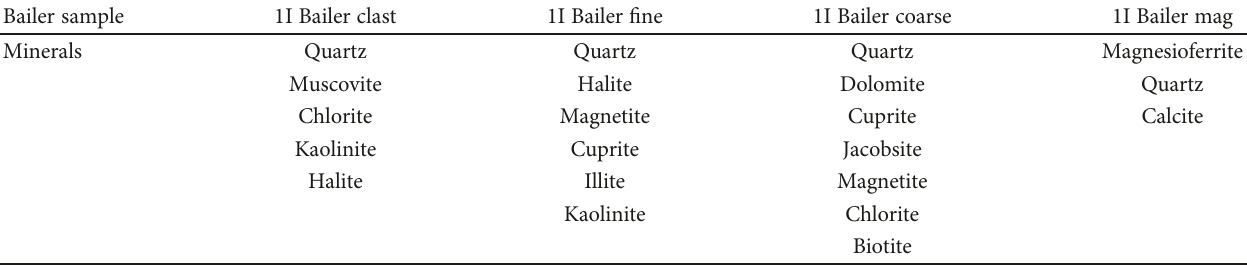
Table 10: Minerals identi fi ed (by X-ray di ff raction) in the bailer sample from borehole 1I sidetrack in 2014. Bailer